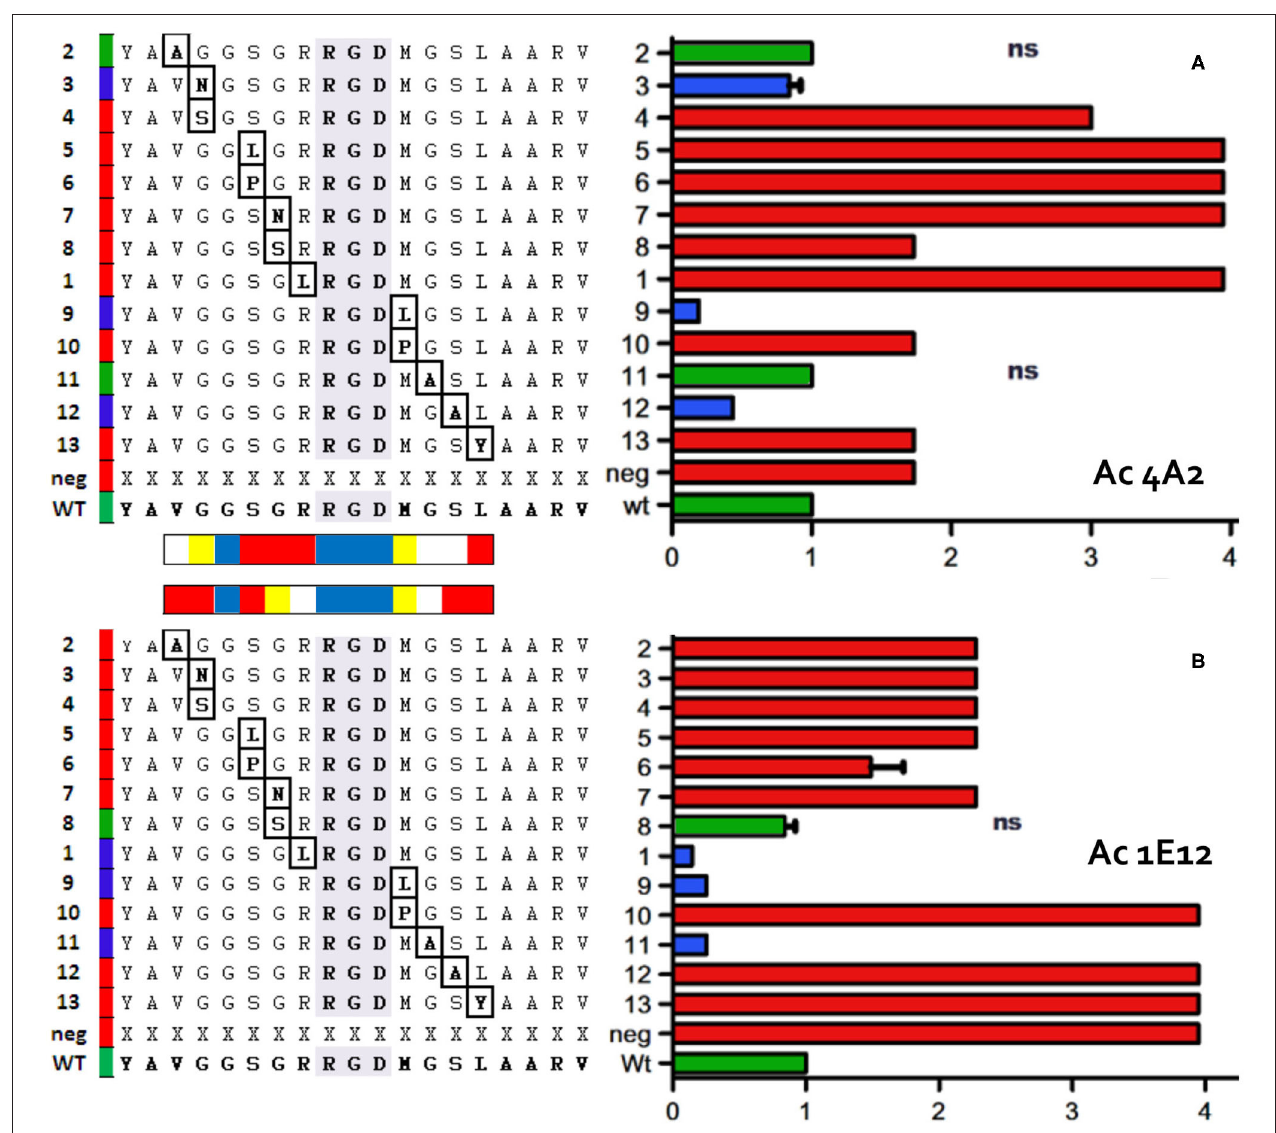
FIGURE 2 | Peptide ELISA mapping of functional epitopes for two anti-FMDV Ab. ELISA results between 15 peptides and mAbs 4A2 or 1E12 are presented in horizontal panels (A,B) , respectively. Each panel: Left, the panel displays the specific aa sequences of each peptide; the point mutation is indicated with a box. Right, the panel shows the influence of the point mutations according to the ELISA data; the colors (in the columns) represent IIR50 relative to the wt peptide as follows: in green, the wt peptide and peptides with mutations of IIR50 (relative interaction index 50) equal to wt; in blue, peptides with IIR50 mutations lower than wt (improve interaction) and in red, peptides with IIR50 mutations greater than wt (worsen interaction). The horizontal bar on each peptide matrix summarizes the positions most affected by the mutations in the functional epitope for each mAb, in red and yellow; positions of low and medium tolerance to mutations, respectively, in blue; non-mutated positions and near-native mutations, in